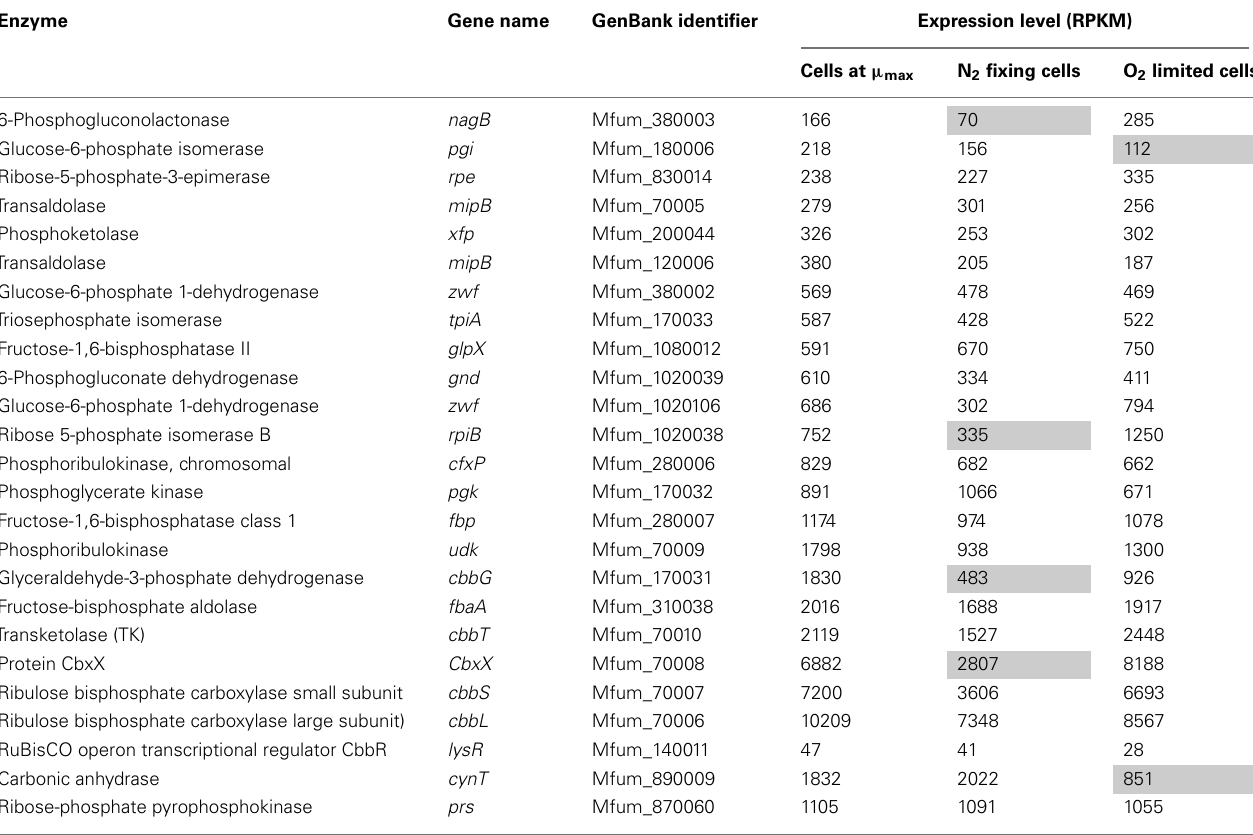
TableA1 |Transcription of genes involved in carbon fixation and the pentose phosphate pathway in “ Ca. M. fumariolicum ” strain